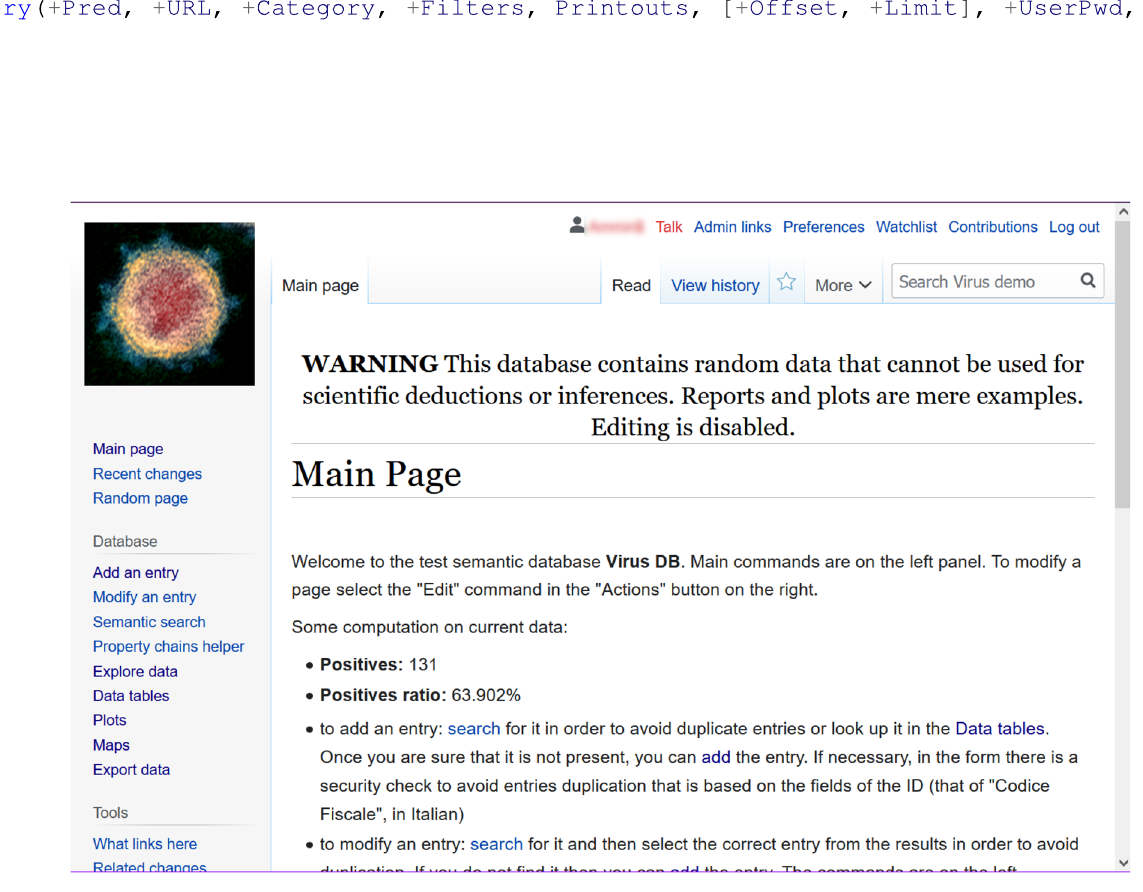
Figure 3. The main page of a typical database: the typical homepage for a generated site in which main operations are explained. It can be customized with a template in tsv2smw or simply by editing its underlying markdown representation. [Screenshots from the public demo site (see Data availability section) taken by the first